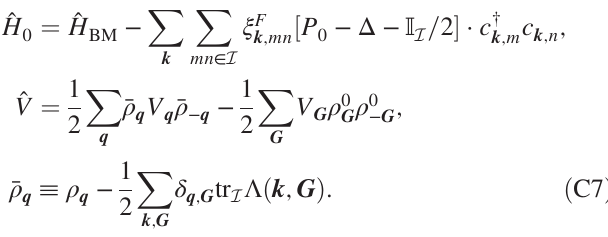
FIG. 8. Bandwidths of electron-hole excitation spectra for bare dispersion (b) θ ¼ 1 . 1 °, and (c) θ ¼ 1 . 2 ° under the subtraction scheme in Eq. (C7). Here, we use ½ð ℏ v and a 6 × 6 system size. The result shows that the bare dispersion near the BM model magic angle θ ¼ 1 . 05 ° is not minimal. Rather, the bare dispersion is suppressed at a slightly higher angle of 1.1°, while at 1.2°, it increases. Therefore, the so-called magic angles for the BM dispersion and bare dispersion are somewhat different. Around the twist angle 1.2°, the bare dispersion is significantly larger than that of θ ¼ 1 . 05 ° throughout the whole range of κ . Based on this figure, we infer that the ground state at this larger angle would be semimetallic even at κ ¼ 0 . 75